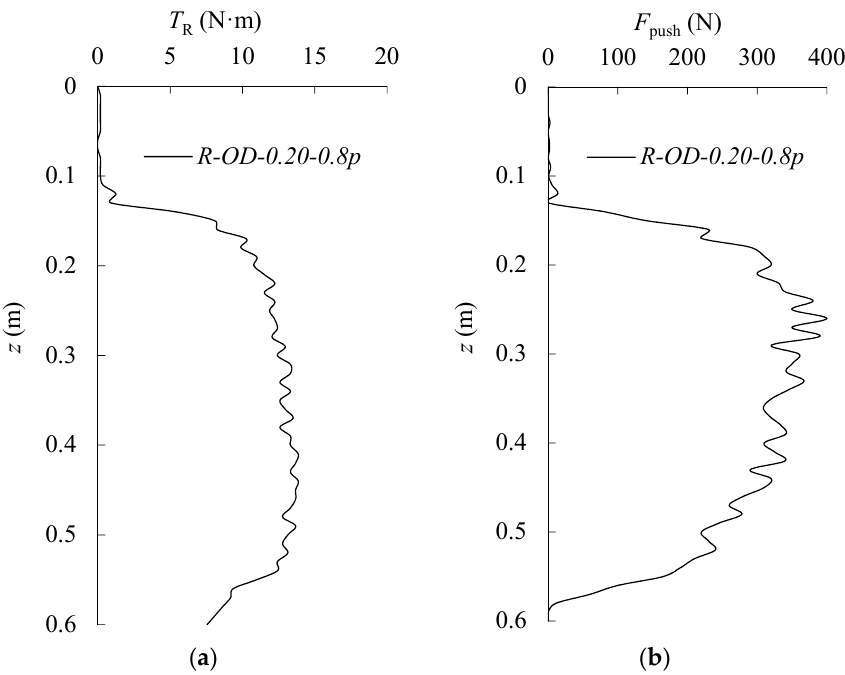
Figure 9. The test results of TN-4. ( a ) Recycling torque. ( b ) Vertical force on shaft.